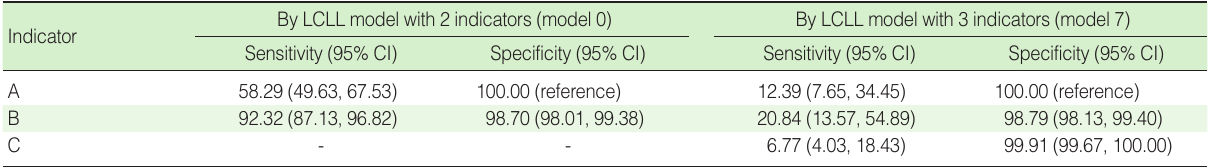
Table 3. Estimated sensitivity and specificity (%) of indicators of illicit drug use in the past 12 months Indicator